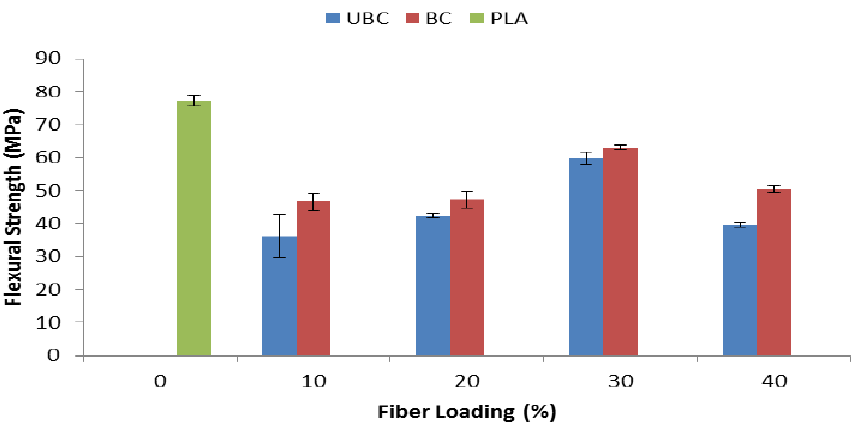
Figure 7. Flexural strength of pure PLA, UBC and BC